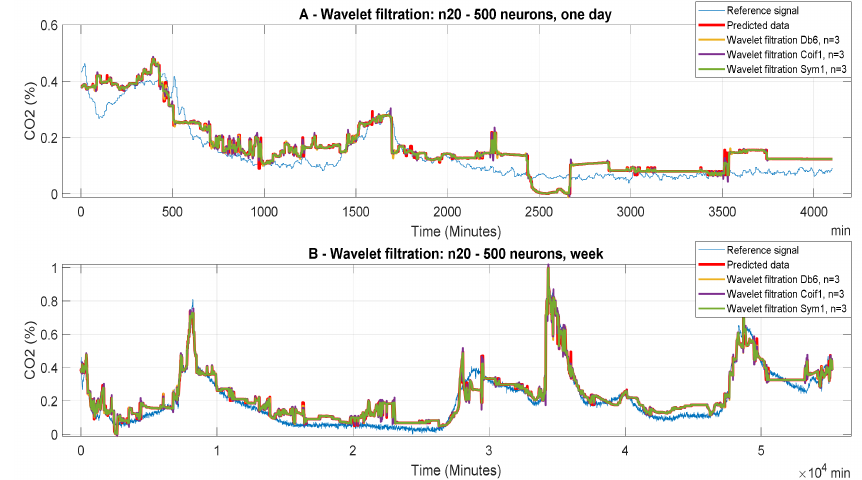
Figure 14. The dependency of CO 2 concentration on the time period for the neural network model 12 (n20 to